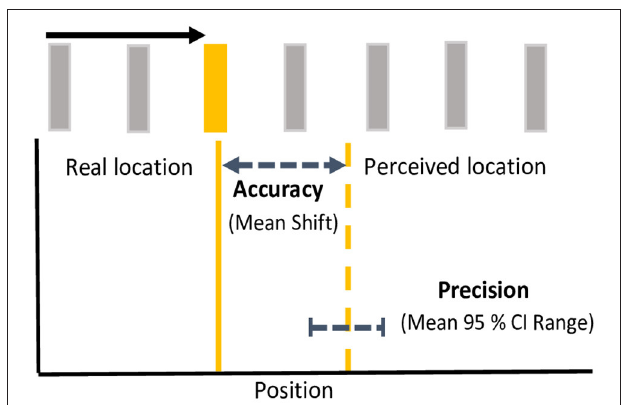
FIGURE 2 | Analytical metrics. For each motion path and flash color, response accuracy was measured as the mean shift between the real location (solid line) and the perceived location (dashed line) of the flash. Response precision was measured as the mean range (upper-lower bound) of 95% confidence intervals for the perceived shifts. Accuracy and precision depicted here is based on mean metrics for yellow flashes in the continuing condition. Note that spacing between bars is exaggerated for